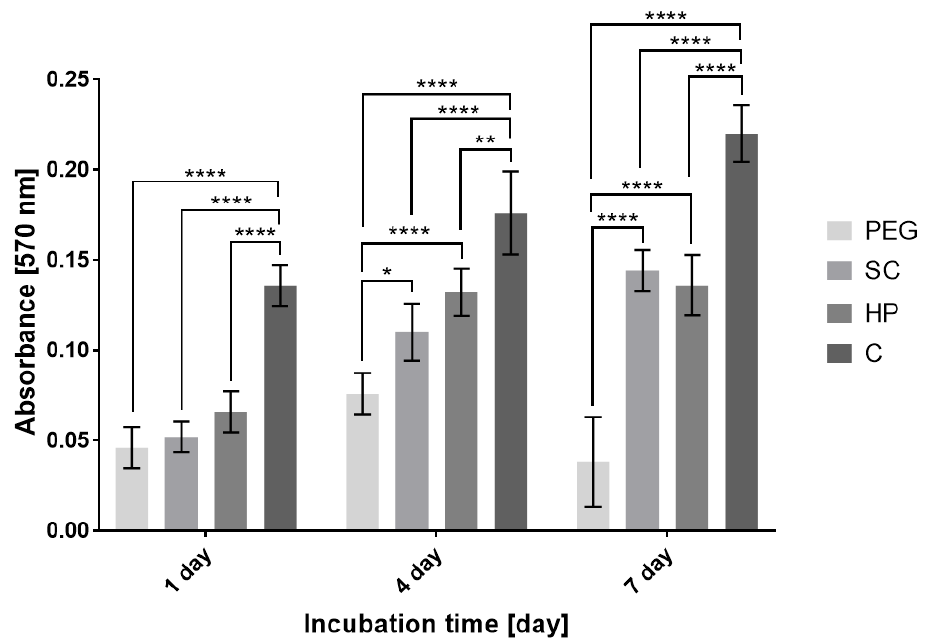
Figure 8. Cell metabolic activity described by the MTT Assay—comparison of the effect of internal bioprinting of different print media on the viability of human osteoblasts (mean value ± standard deviation, n = 4). Statistically significant difference in the significance level: * p < 0.04; ** p < 0.002;